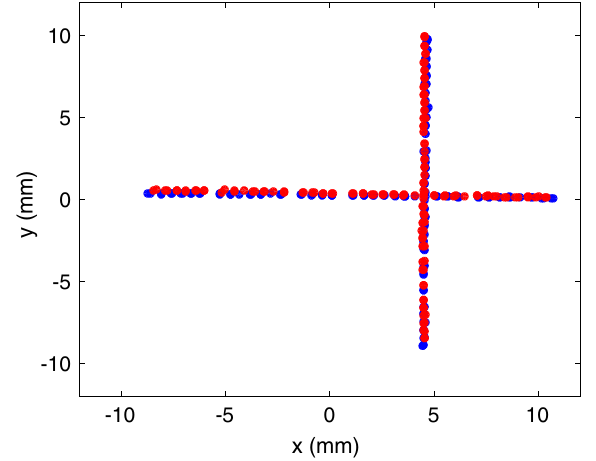
FIG. 18. Beam position reading of the HOMBPM in cavity three (red) and the prediction from the others (blue) for a horizonthal and vertical scan with rf and magnets on.